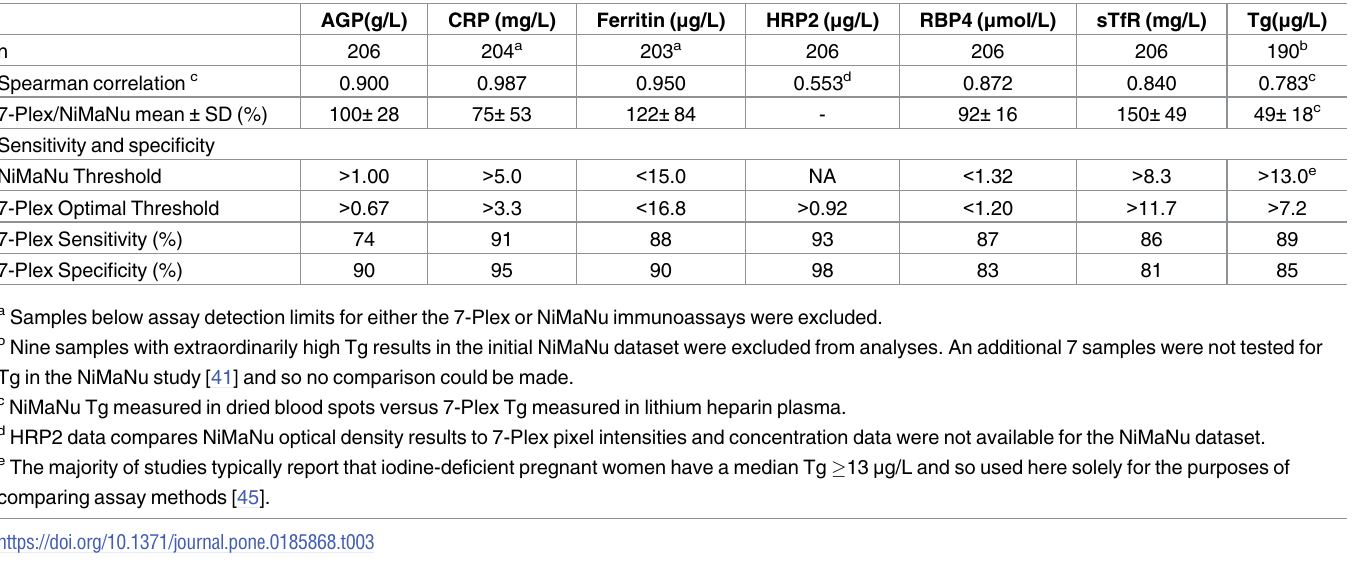
Table 3. Spearman correlations and recovery,7-Plex assaysvs NiMaNu